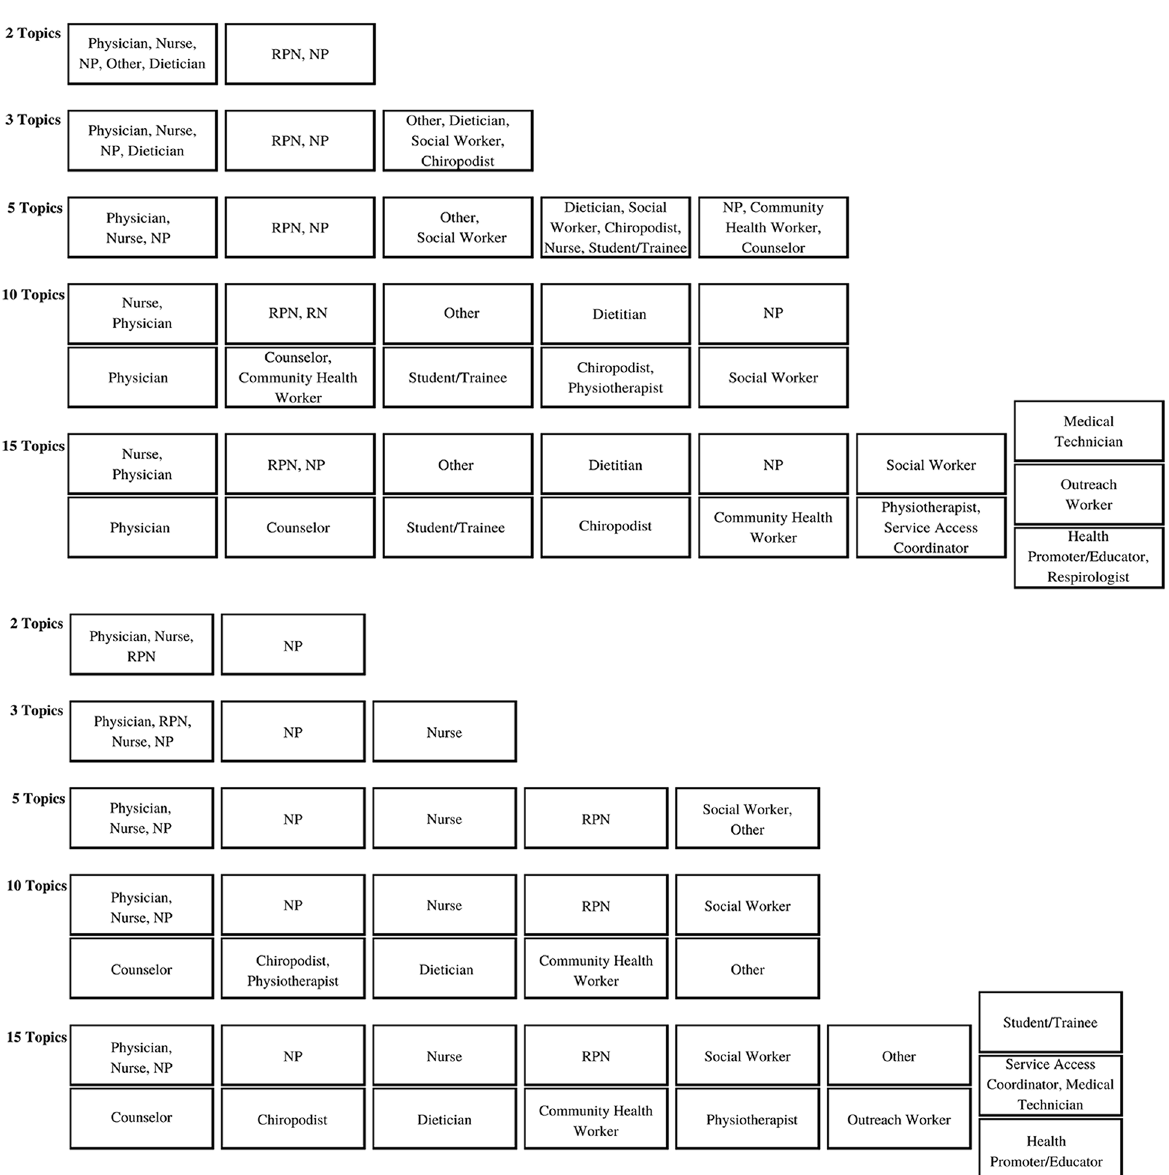
Figure 3: Common care provider